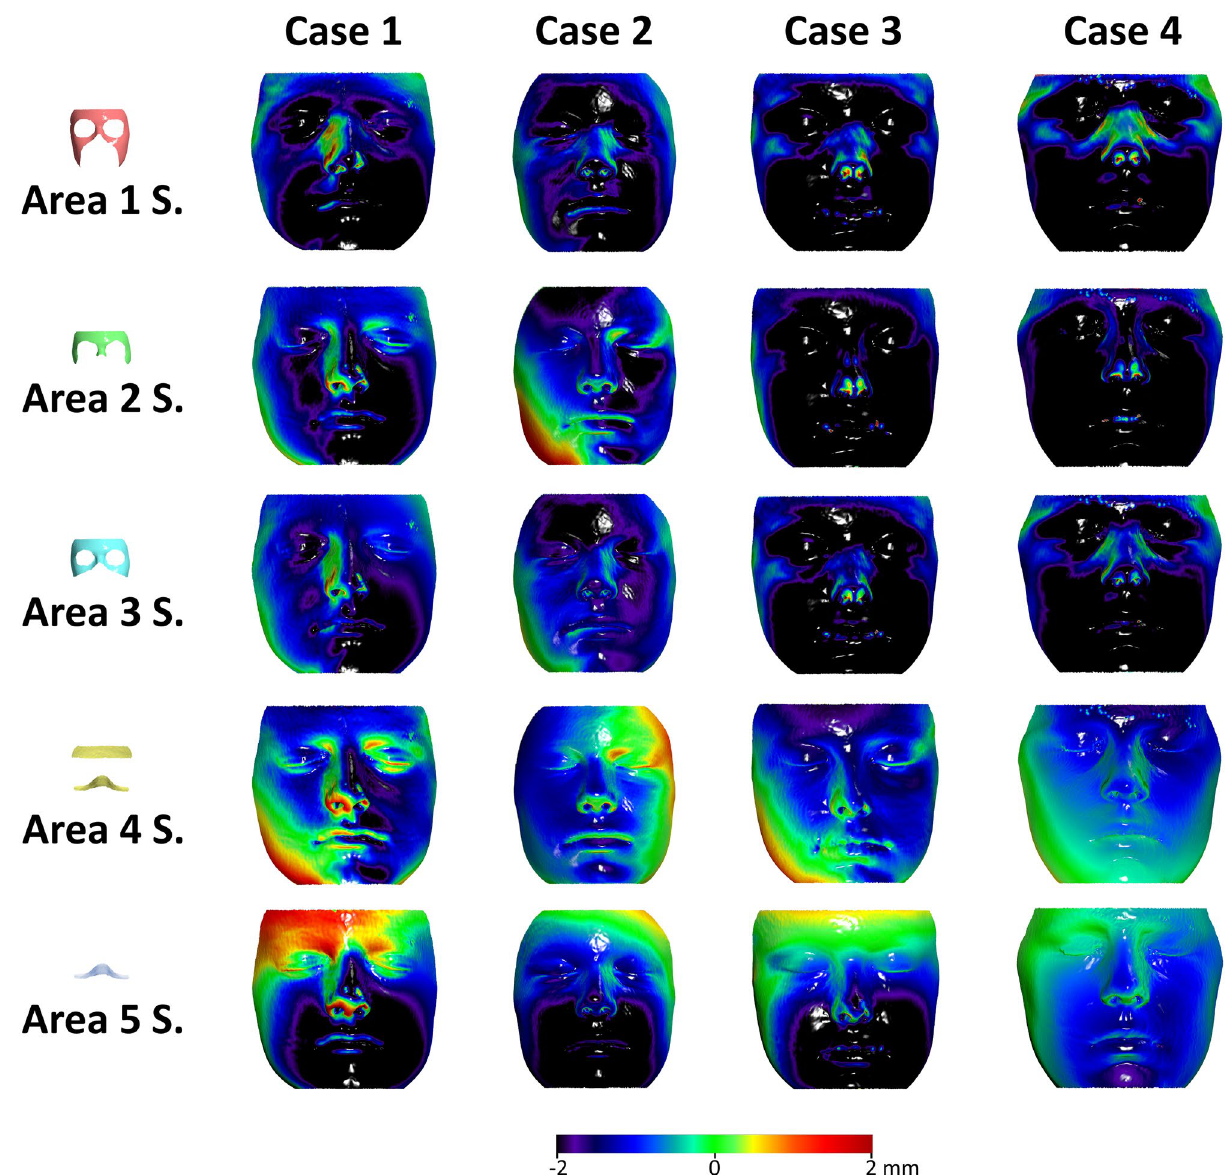
Figure 3. Colour coded distance maps showing the differences in the outcomes (T1 models) of the five different facial surface-based superimpositions from the anterior cranial base voxel-based superimposition, on four representative cases. The voxel-based superimposition T1 surface model was used as a reference. S.: Superimposition. All images were generated using Viewbox 4 software (version 4.1.0.1 BETA, http:// www. dhal. com/ viewb oxind ex.